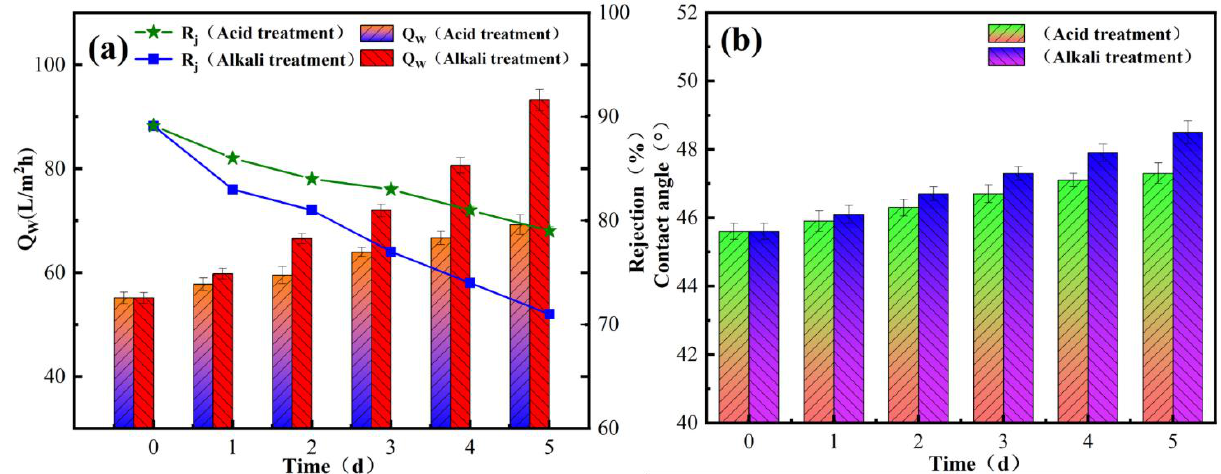
Figure 16. IP–ZrO 2 /BC–NFM under acidic–alkaline conditions (pH values of 2 and 10): ( a ) membrane flux and Na 2 SO 4 rejection; ( b ) contact angle.